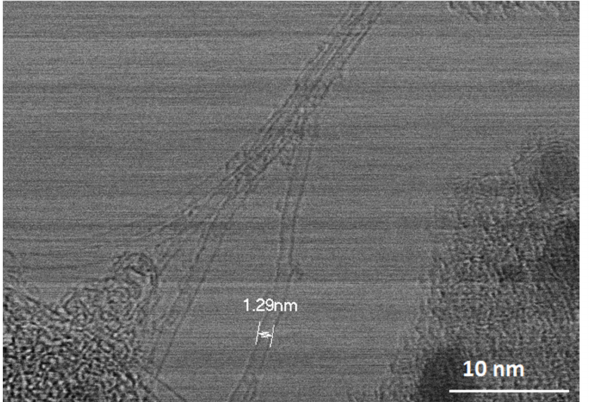
Figure 4. Measurement of individual SWCNT diameter by HR-STEM.